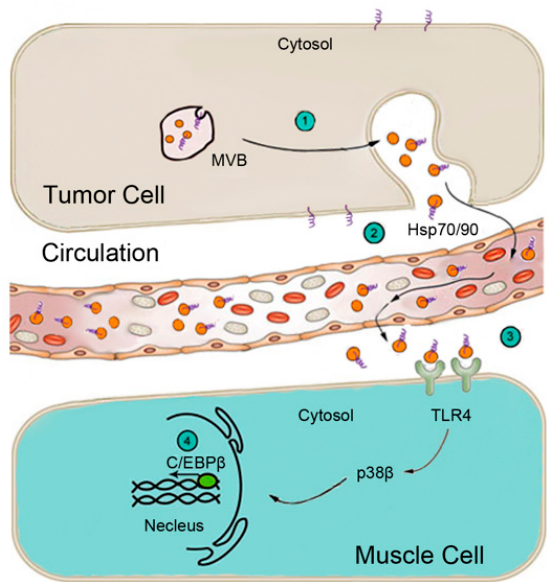
Figure 2. Schematic representation of the mechanism for cancer induction of muscle wasting through the release of EV-associated Hsp70 and Hsp90 that activate TLR4 on muscle cells. (1) Multivesicular bodies (MVBs) in tumor cells fuse with the plasma membrane releasing EVs (orange balls). (2) Circulating EVs carry surface Hsp70 and Hsp90 (purple loops). (3) Hsp70 / 90-carrying EVs activate TLR4 on muscle cells. (4) TLR4 activation of p38 β MAPK upregulates rate-limiting genes in UPP and ALP via C / EBP β